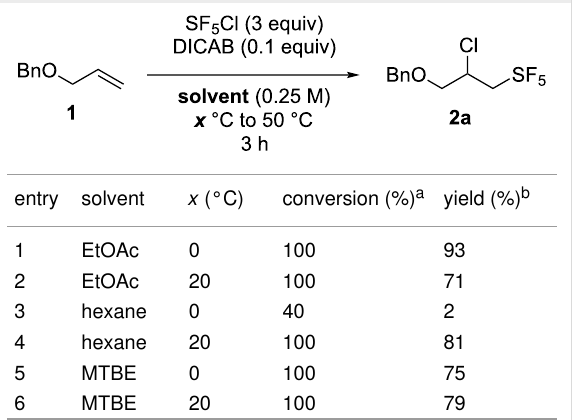
Table 4: Effect of the initial temperature on the SF 5 Cl addition on allyl benzyl ether ( 1 ).